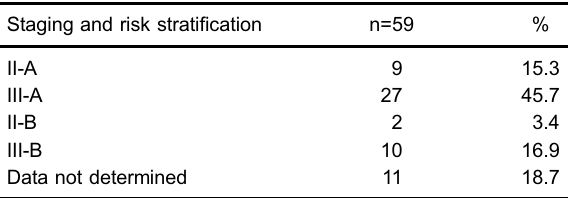
Table 3. Durin-Salmon staging and risk strati fi cation of multiple myeloma patients under treatment with bortezomib, thalidomide, or a combination of both drugs.